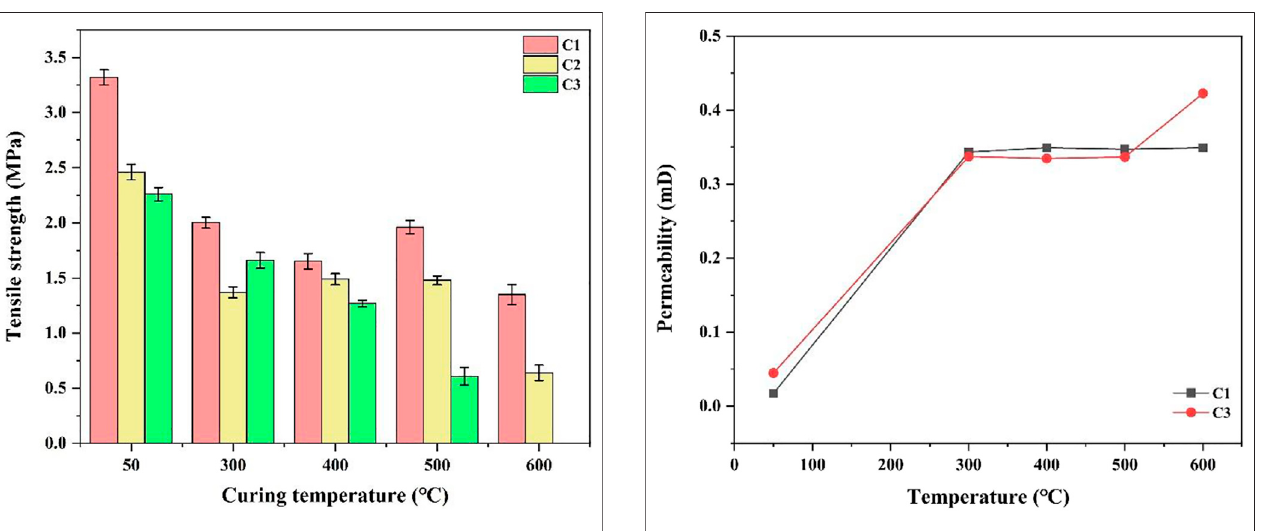
FIGURE 6 | Permeability of C1 and C3 cement pastes at different temperatures.